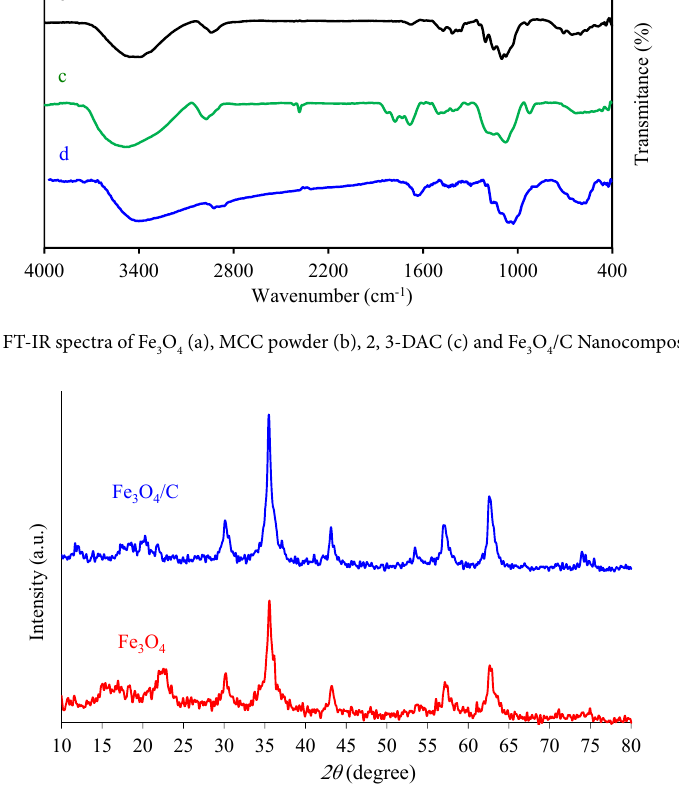
O /C Nanocomposite and Fe 3 4